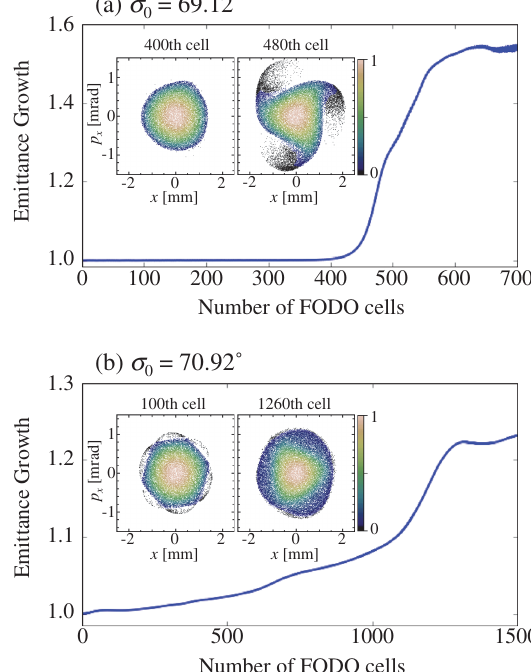
FIG. 3. Transverse rms emittance evolution of a waterbag beam propagating through a long FODO channel with ξ ¼ 0 . 5 and ζ ¼ 1 . The initial tune depression is set at η ¼ 0 . 8 in both examples. The bare phase advance in the upper picture (a) is σ ¼ 69 . 12 ° while in the lower picture (b), the operating point is 0 slightly moved to σ 0 ¼ 70 . 92 ° within the same local instability band. The external potential includes no nonlinearity. Two insets in each picture exhibit the horizontal phase-space profiles after the waterbag beam has passed through certain numbers of FODO cells; namely, the profiles at the 400th cell and at the 480th cell in the upper picture, and the profiles at the 100th cell and at the 1260th cell in the lower. Following the PIC simulations in Fig. 2, we have assumed a 1 MeV proton beam with the initial emittance (90%) of 0 . 88 π mm ·